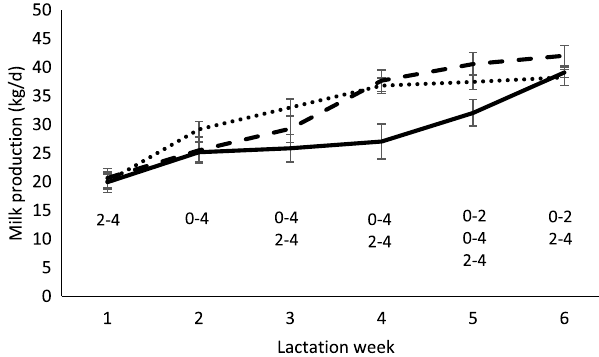
Figure 4. Machine milk yield (mean ± SEM) for the first 6 weeks of lactation of cows separated from their calves at birth (dotted line), after 2 weeks (dashed line) or after 4 weeks (continuous line). Significant differences between different separation times are indicated on the graph: e.g. 0–2 = 0 week and 2 weeks separation groups differ.